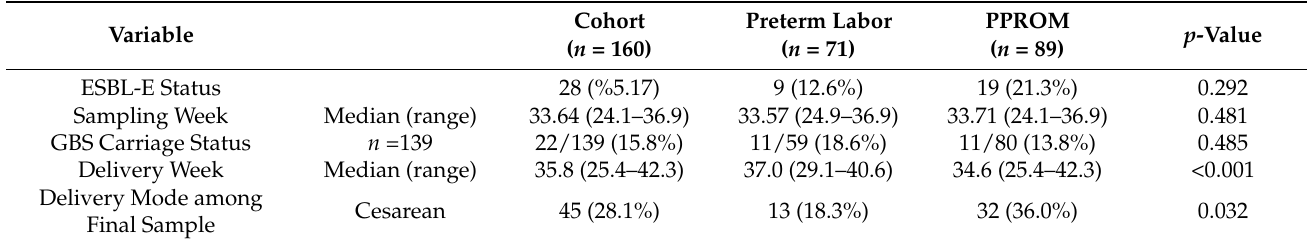
Table 2. Obstetric outcomes stratified by PPROM and preterm labor.